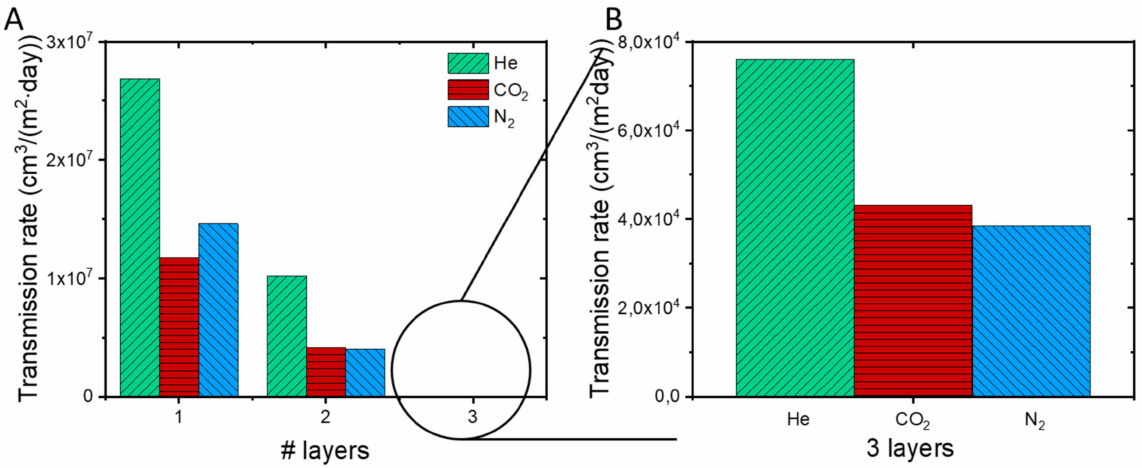
Figure 3. ( A ) Single gas permeability (He, CO 2 and N 2 ) of ASR-stabilized waterborne coatings on paperboard having one, two or three coating layers. ( B ) Zoom in on the triple-coated